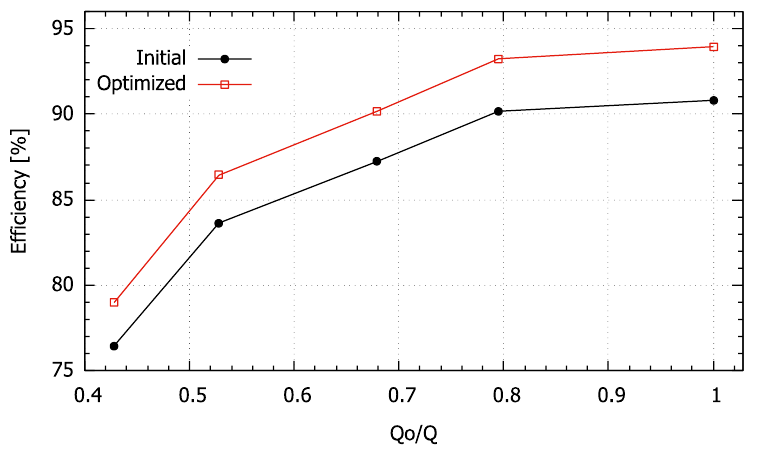
Figure 15. Influence of L parameter.